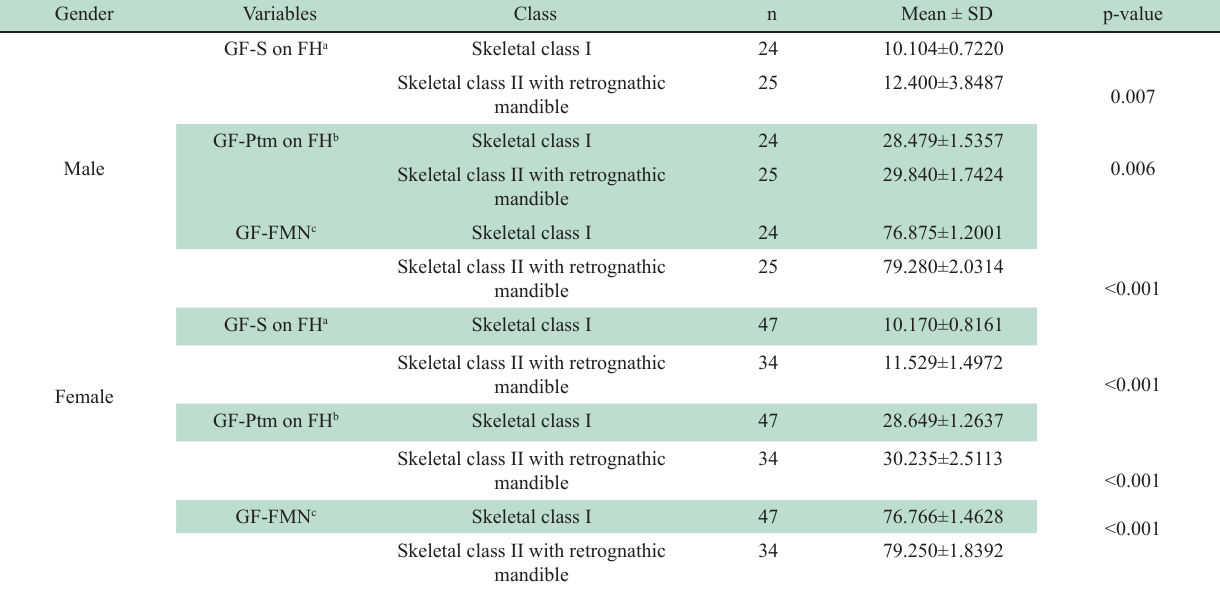
Table-IV: Comparison of GF-S on FH, GF-Ptm on FH and GF-FMN in Skeletal class I and Skeletal class II with retrognathic mandible in males and females.